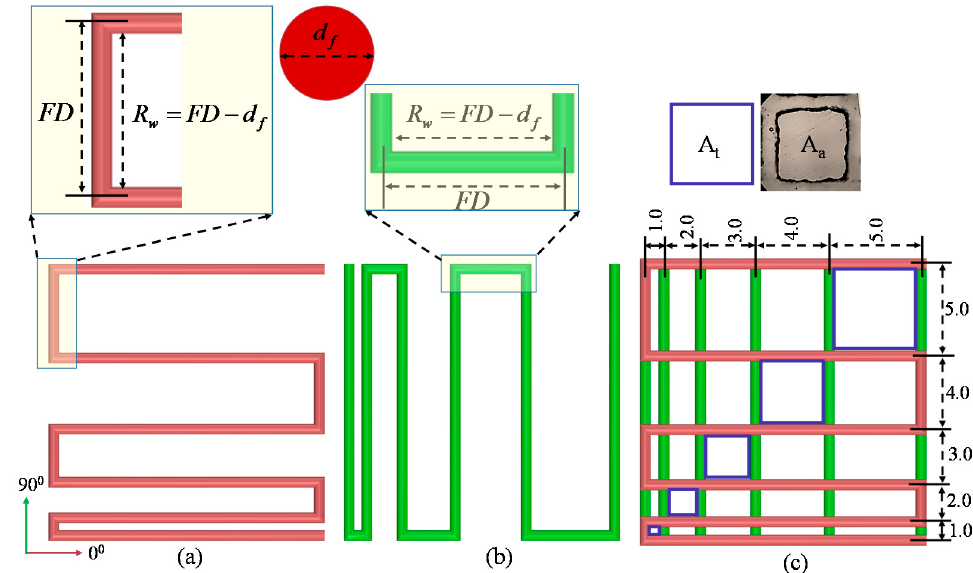
Figure 4. Filament deposited along ( a ) 0°, ( b ) 90° and ( c ) 0°–90°.